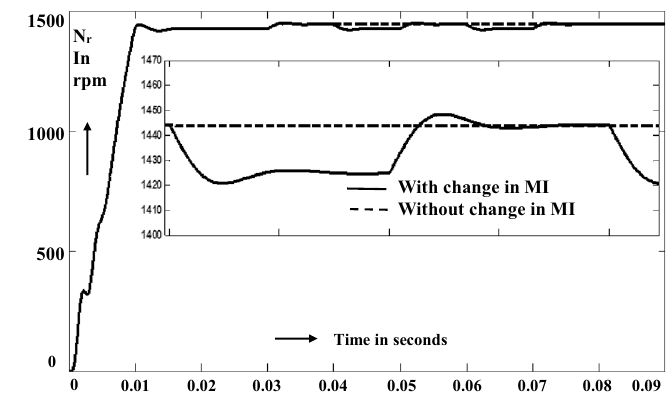
Fig. 15 Speed variation without and with changing